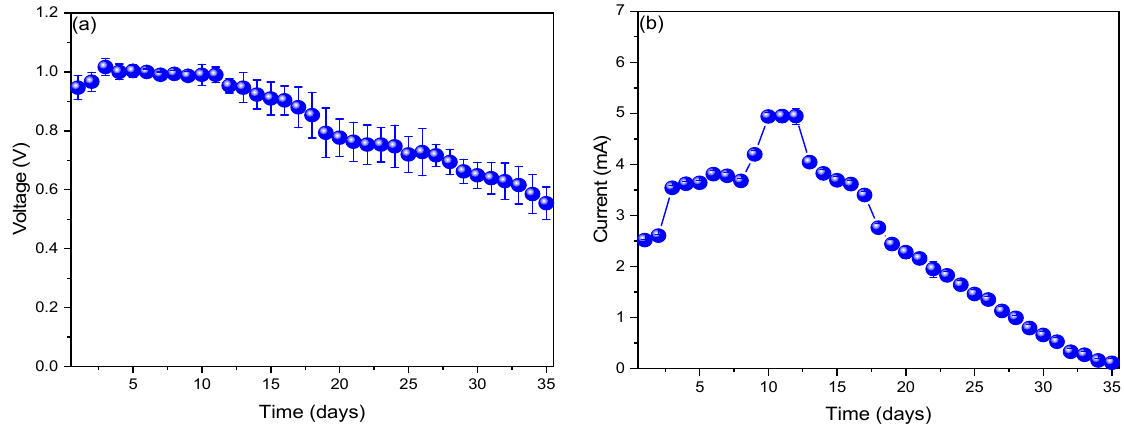
Figure 2. Values of ( a ) voltage and ( b ) current generated during the 35 days of monitoring.